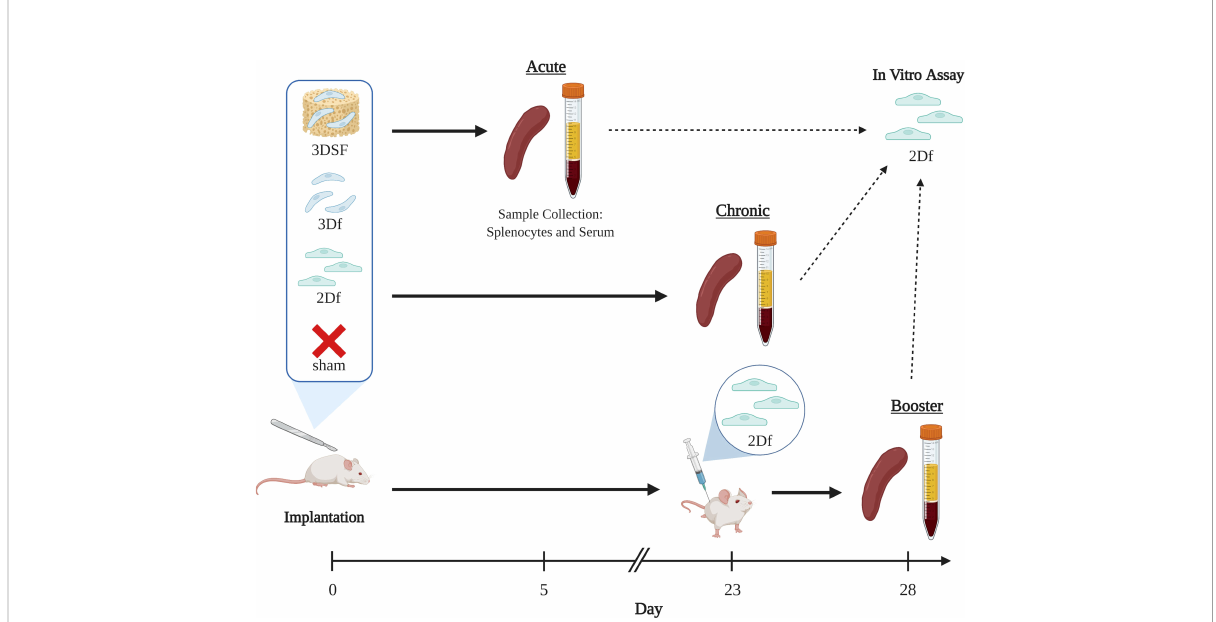
FIGURE 3 Experimental groups and time scales for in vivo studies. The effect of implantation of allogeneic ECs on immune response was measured over three different time scales. Brown Norway ECs were implanted subcutaneously in Lewis rats. Animals were implanted with either i) 2D ECs freed from TCP with trypsin (2Df), ii) 3D ECs that were implanted on their scaffolds (3DSF), iii) 3D ECs freed from the scaffold with trypsin (3Df), and iv) surgery but no implants (sham). Acute animals were implanted for 5 days and chronic animals were implanted for 28 days. Booster